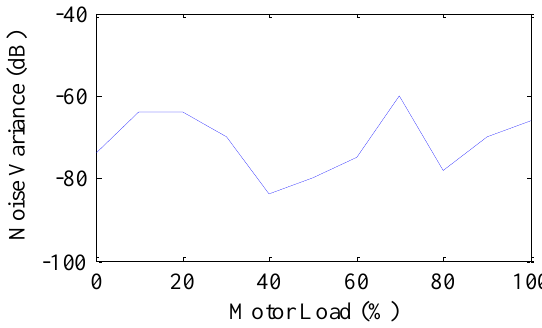
Figure 9. The relation of environment noise variations with motor load.